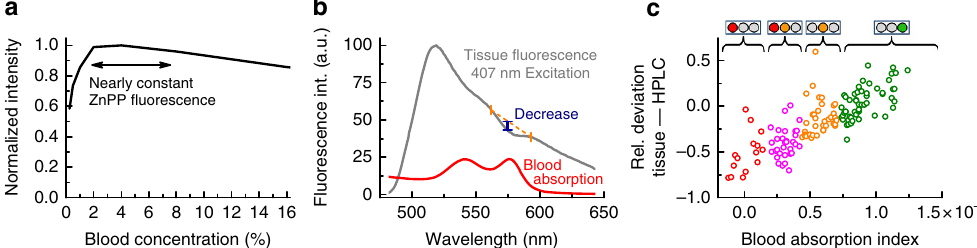
Figure 3 | Using the blood absorption index to identify suitable tissue sites for quantitative measurement of the ZnPP/haem ratio. ( a ) For whole-blood concentrations between 2 and 8% (whole blood of a healthy subject diluted by saline), the measured ZnPP fluorescence remains little changed despite this large variation in the blood concentration. ( b ) Illustration of the blood absorption index. The magnitude of the decrease in the tissue-background fluorescence spectrum resulting from blood absorption, termed the ‘blood absorption index’, is continuously analysed during the measurement by evaluating three spectral bands centred at 562, 576 and 593nm, around a blood absorption peak. ( c ) The blood absorption index in relation to the relative deviation of the measured values in vivo from HPLC reference values in vitro . Data from 10 measurement sites from each of 14 subjects are shown. To guide the examiner to a site on the lower lip with an adequate blood absorption index, feedback by an indicator light is given as red, red-orange, orange and green. Measurements are only started at sites with a blood absorption index 4 0.7 (cid:2) 10 (cid:3) 2 (green) to ensure that the relationship between the detected red blood cell ZnPP fluorescence and the ZnPP/haem ratio is